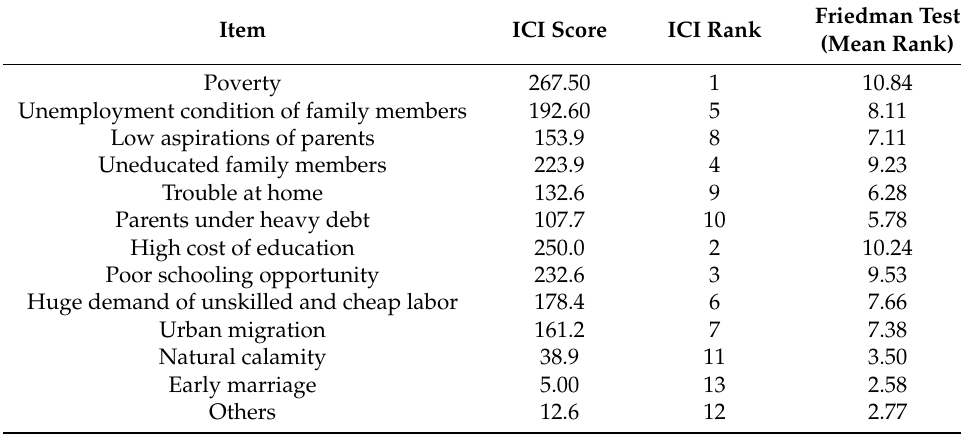
Table 3. Influencing Cause’s Index (ICI) and Friedman Test Rank order of 13 selected causes faced by the child laborers. Item ICI Score ICI